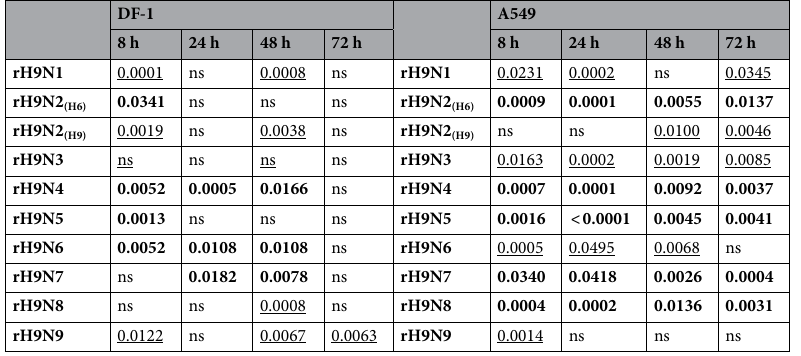
Table 3. List of p-values generated from Tukey multiple comparison of the replication kinetics data, comparing the mean TCID 50 between rH9Nx with intact neuraminidase stalk and parental chH9N2 virus in both DF-1 and A549 cells. P-values less than 0.05 were considered significant. Bold p-values indicate significantly higher mean TCID 50 value at a given timepoint. Underlined p-values indicate significantly lower TCID 50 at a given timepoint. Non-significant comparisons are denoted